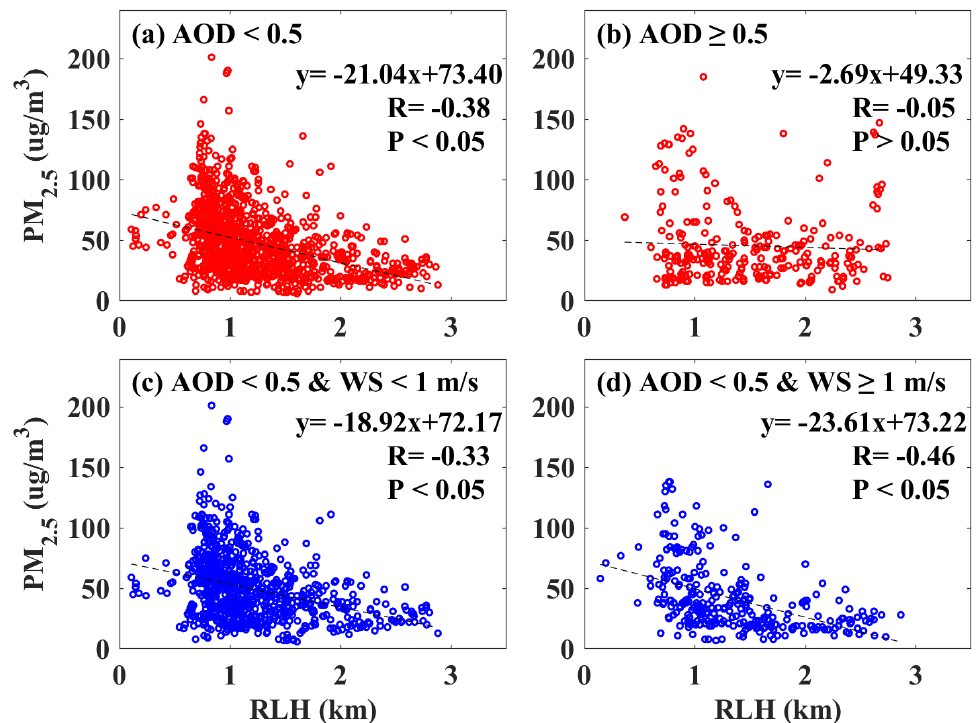
Figure 9. Correlations between hourly mean RLHs and PM 2.5 at ( a ) low, and ( b ) high AOD periods. Correlations between hourly mean RLHs and PM 2.5 at low AOD periods with ( c ) WS < 1 m/s, and ( d ) WS ≥ 1 m/s. The black dotted line represents the linear fitting curve. The correlation coefficients (R) and fitted function are provided in the higher right corner of each panel.